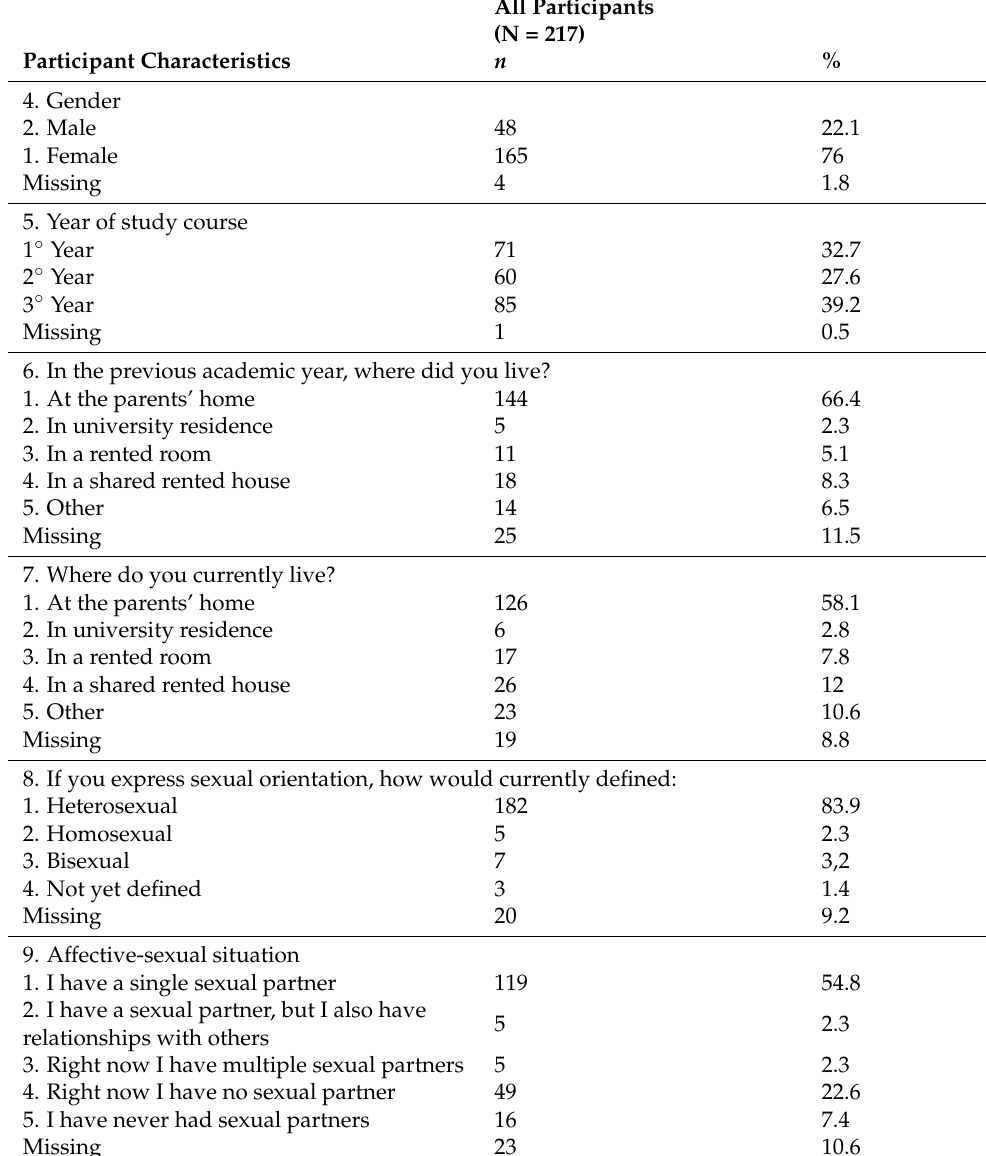
Table 1. Characteristics of